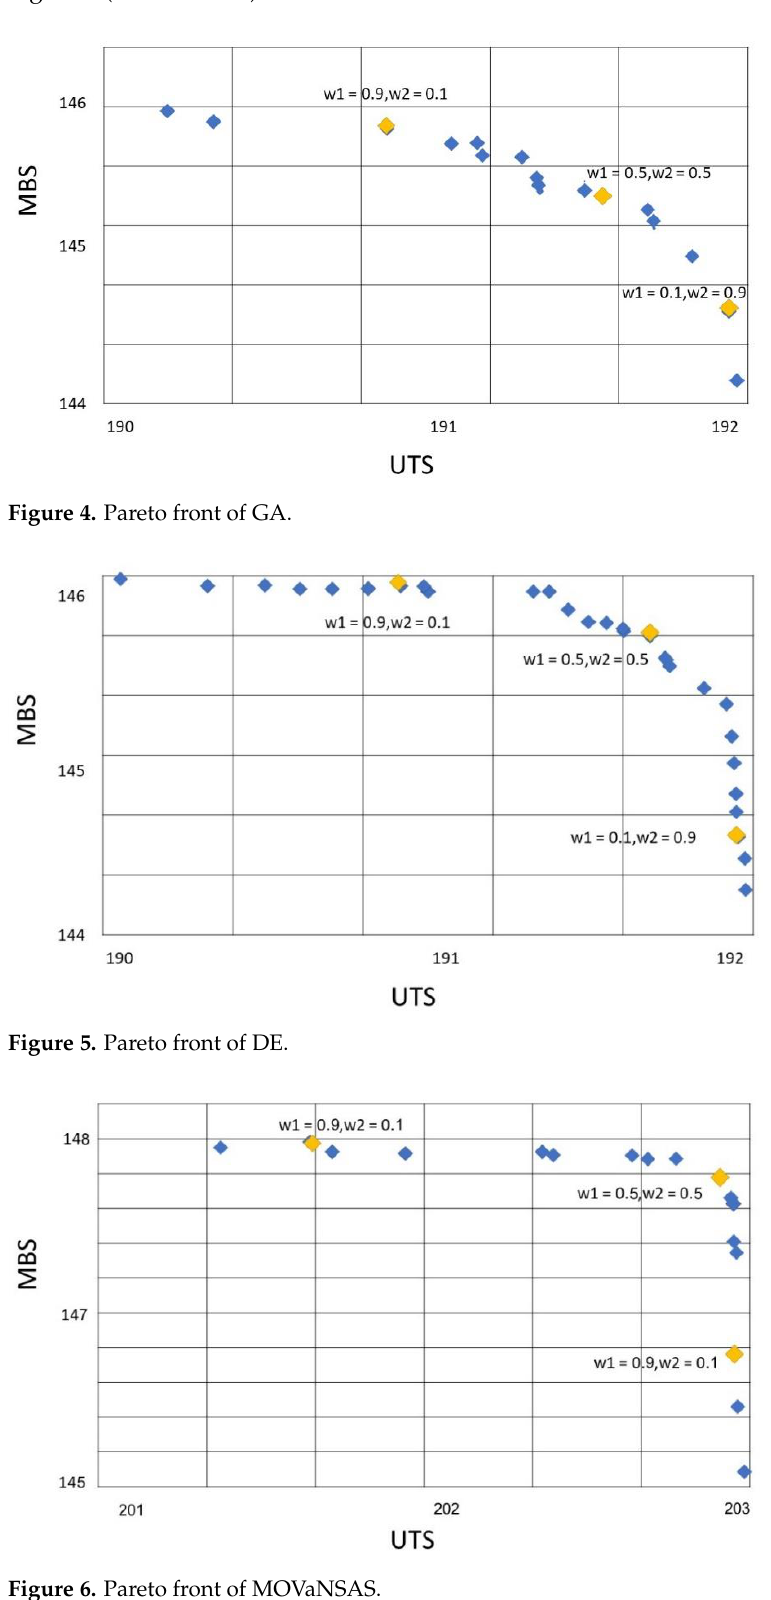
Figure 6. Pareto front of MOVaNSAS.